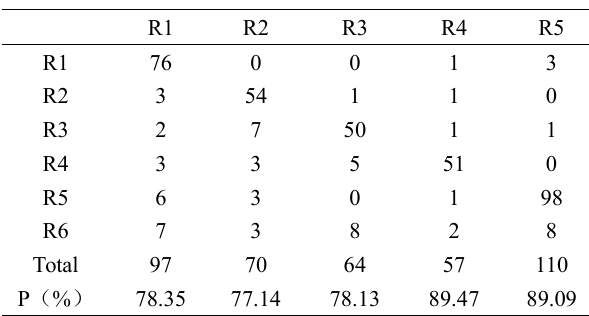
Note: R1-R6 represent extremely rocky desertification, strength rocky desertification, moderate rocky desertification, slight rocky desertification, potential rocky desertification and non-rocky desertification. U and P represent respectively user accuracy and produced